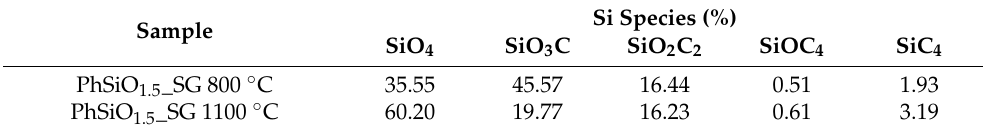
Table 2. Percentage of each SiO x C 4 − x Si species calculated from 29 Si MAS NMR.